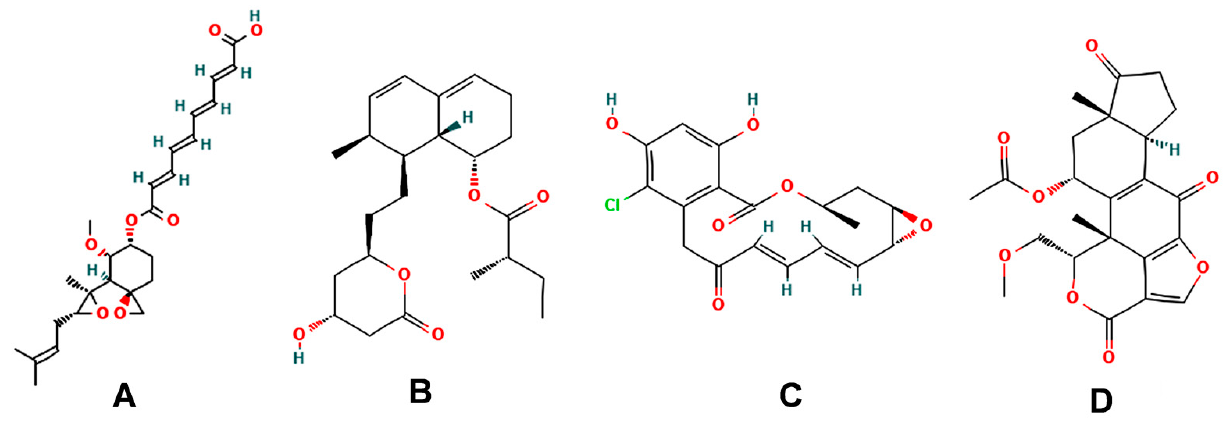
Figure 1. Chemical structure of four mycotoxins: ( A ) fumagillin (C 26 H 34 O 7 , MW: 458.5), ( B ) mevas- tatin (C 23 H 34 O 5 , MW: 390.5), ( C ) radicicol (C 18 H 17 ClO 6 , MW: 364.8), and ( D ) wortmannin (C 23 H 24 O 8 , MW: 428.4).